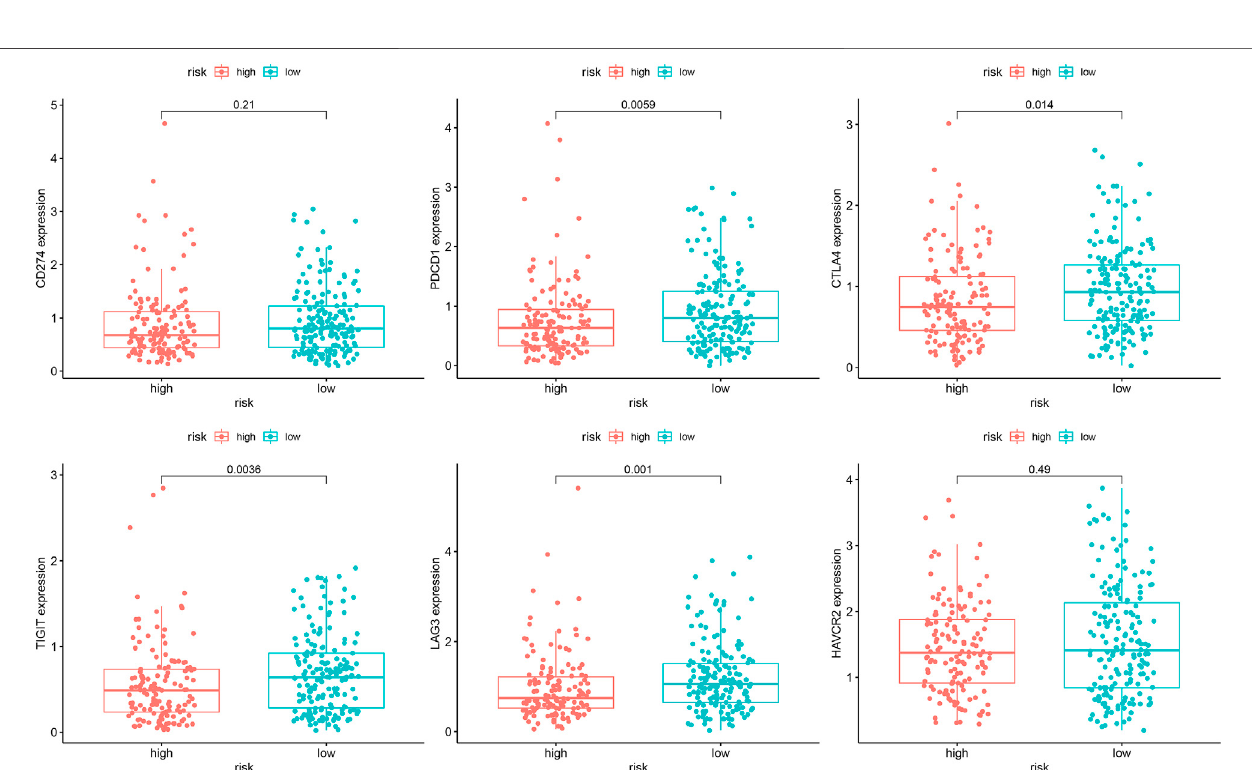
FIGURE 10 | The difference of the expression of immunosuppressive checkpoints within different risk groups.